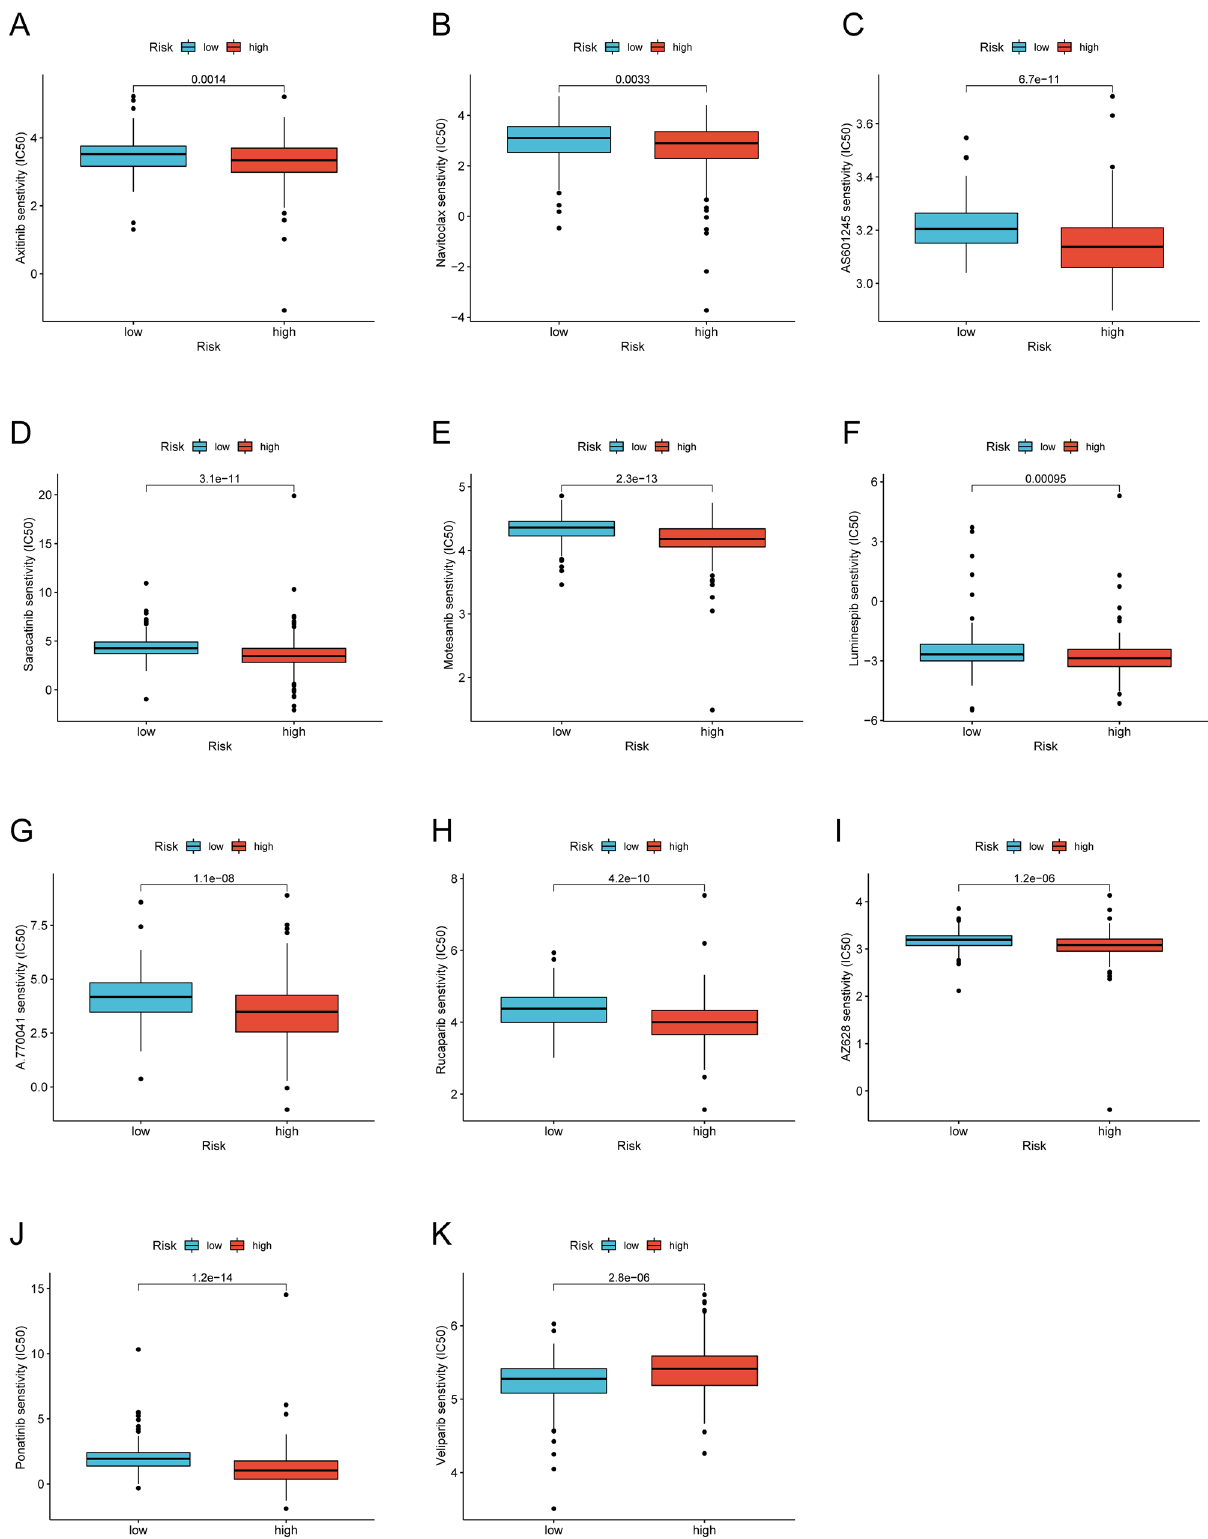
Figure 11. Drugs sensitivity analysis in patients from different risk score groups. The sensitivity to chemotherapeutic drugs was represented by the half-maximal inhibitory concentration (IC50) of chemotherapeutic drugs. ( A – K ) Comparisons of IC50 for chemotherapeutics drugs between two subgroups revealed that the high-risk group was more likely to benefit from the treatments (Kruskal–Wallis test, all p <